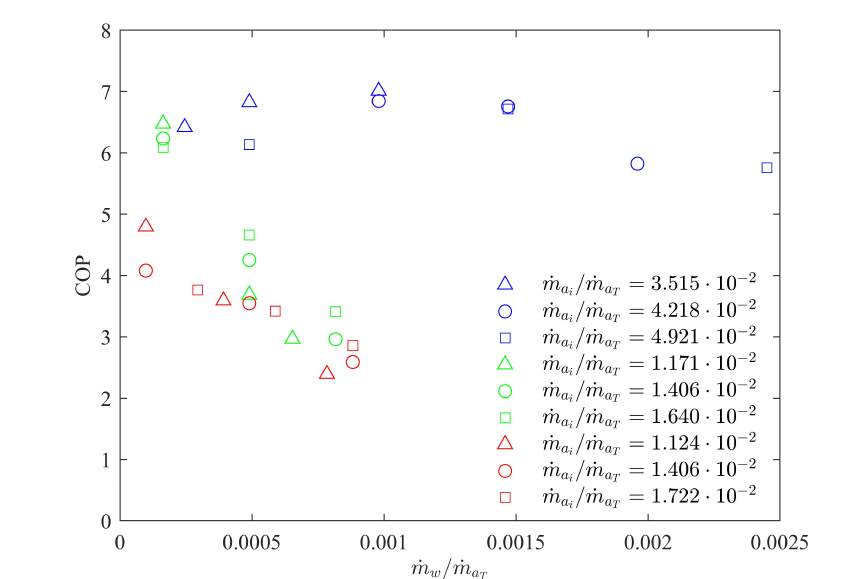
Figure 13. Coefficient of performance as a function of the water-to-air mass flow ratio for all the simulations